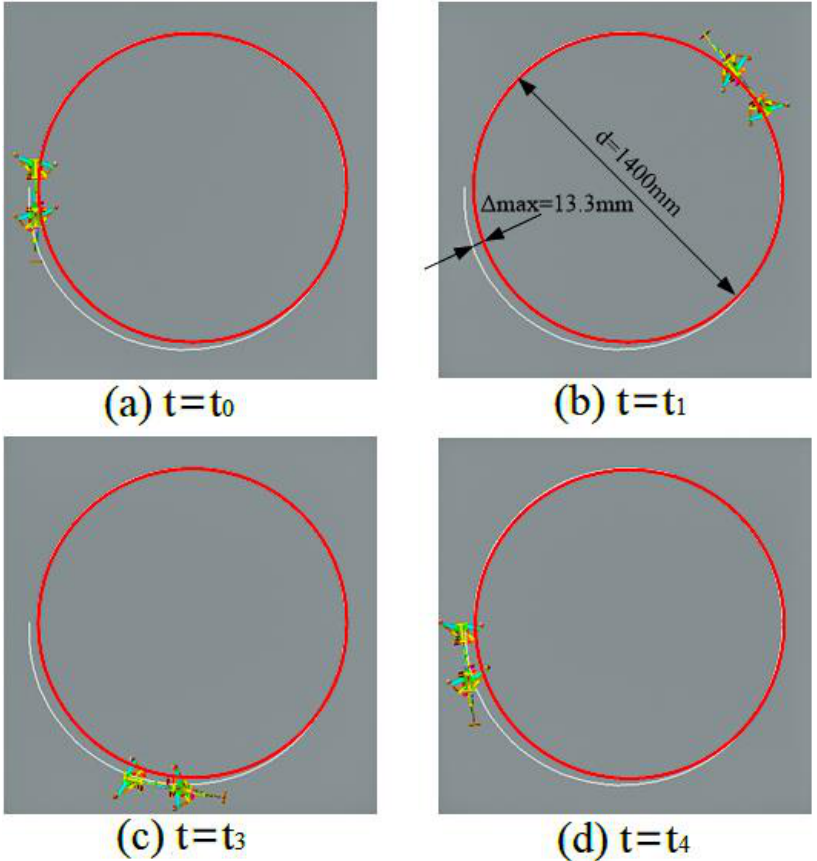
Figure 9. Turning movement of the robot using a diagonal gait in ADAMS in different moments.